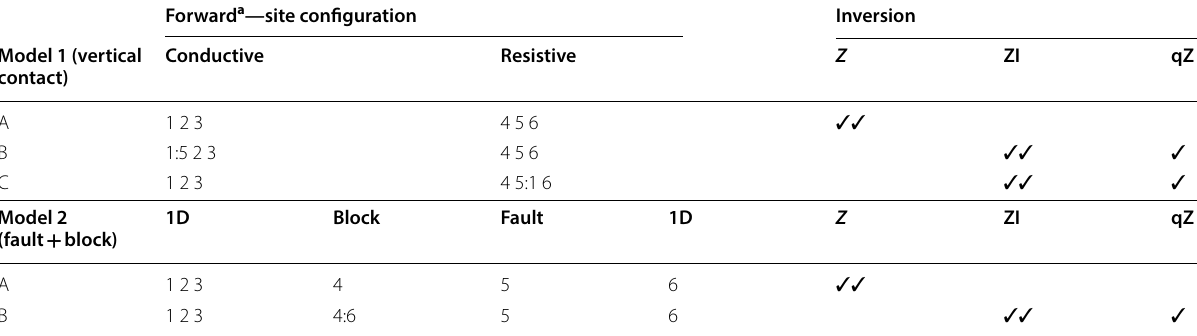
The forward column indicates at which sites Z and ZI were calculated. The inversion column indicates which inversions were performed ( Z , ZI or qZ) and the validity of the obtained models (good ✓✓ , or regular ✓ ) a One number indicates the site number; two numbers separated by a colon indicates where the site’s electric and magnetic fields were recorded,